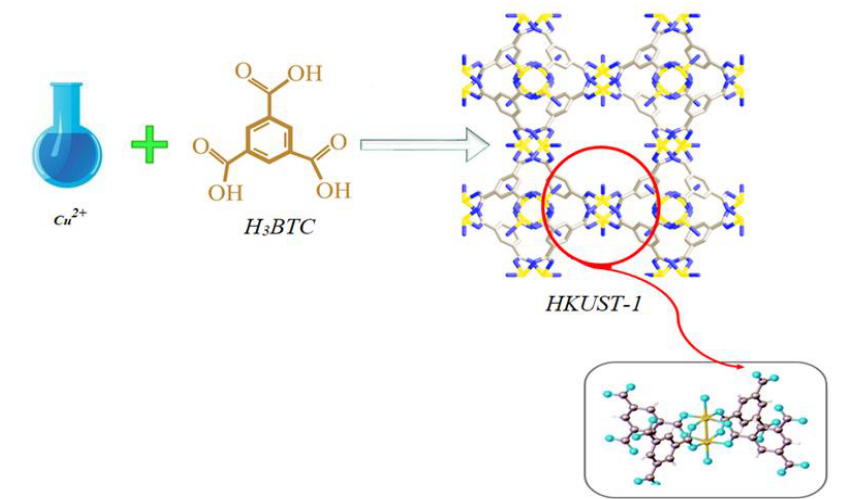
Fig. 2. Schematic of synthesis of the metal-organic framework Fig 2: Schematic of Synthesis of the metal-organic framework HKUST-1